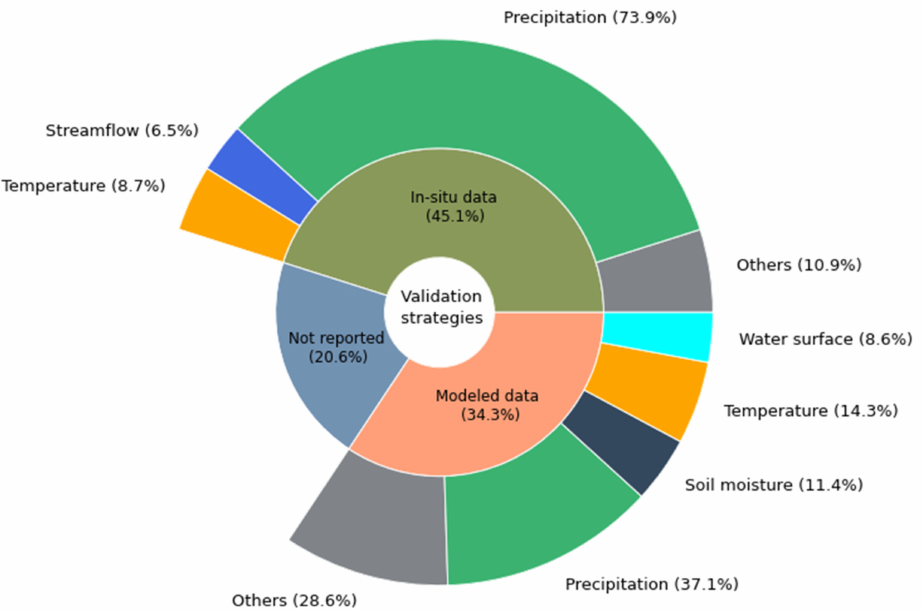
Figure 9. The validation strategies and data used in the corresponding strategies. The inner chart presents validation strategies, whereas the outer chart depicts the specific data used to validate the produced drought products. This review considered the major validated data, but it is admitted that few studies are reported to use more than one data type for